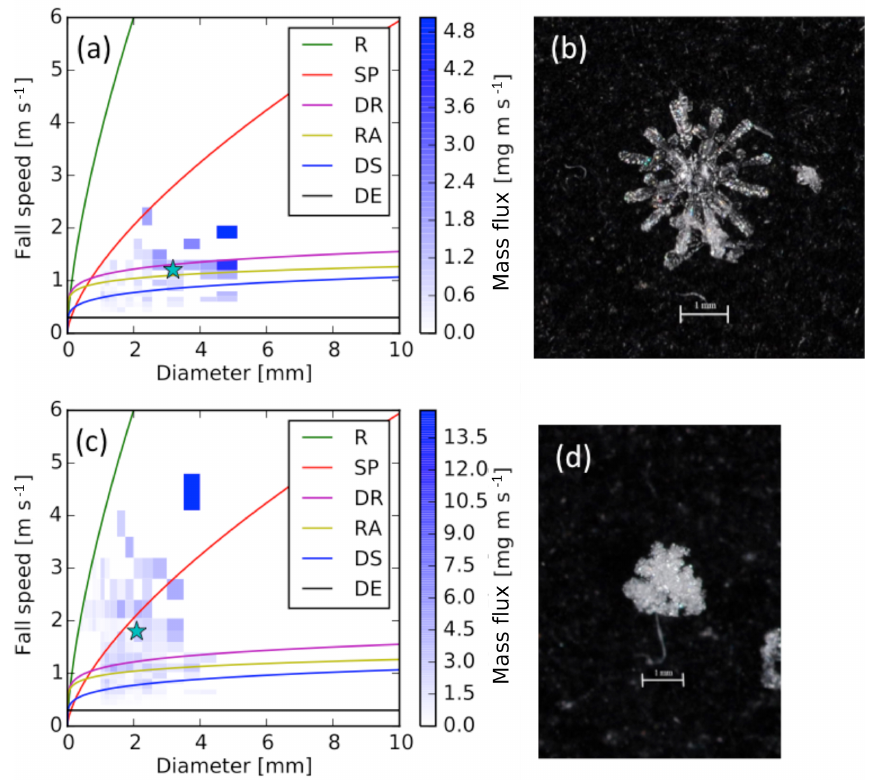
Figure A2. (a, c) The 5min average of the fall-speed–diameter distributions within which two types of snow have been diagnosed using the Ishizaka et al. (2013) method. (b, d) are the associated snowflake images, respectively. The green star indicates the CMF associated with the main type of particles. (a, b) is associated with a rimed particles and (c, d) is associated with snow pellet. The abbreviations of particle types are defined in Table A1.